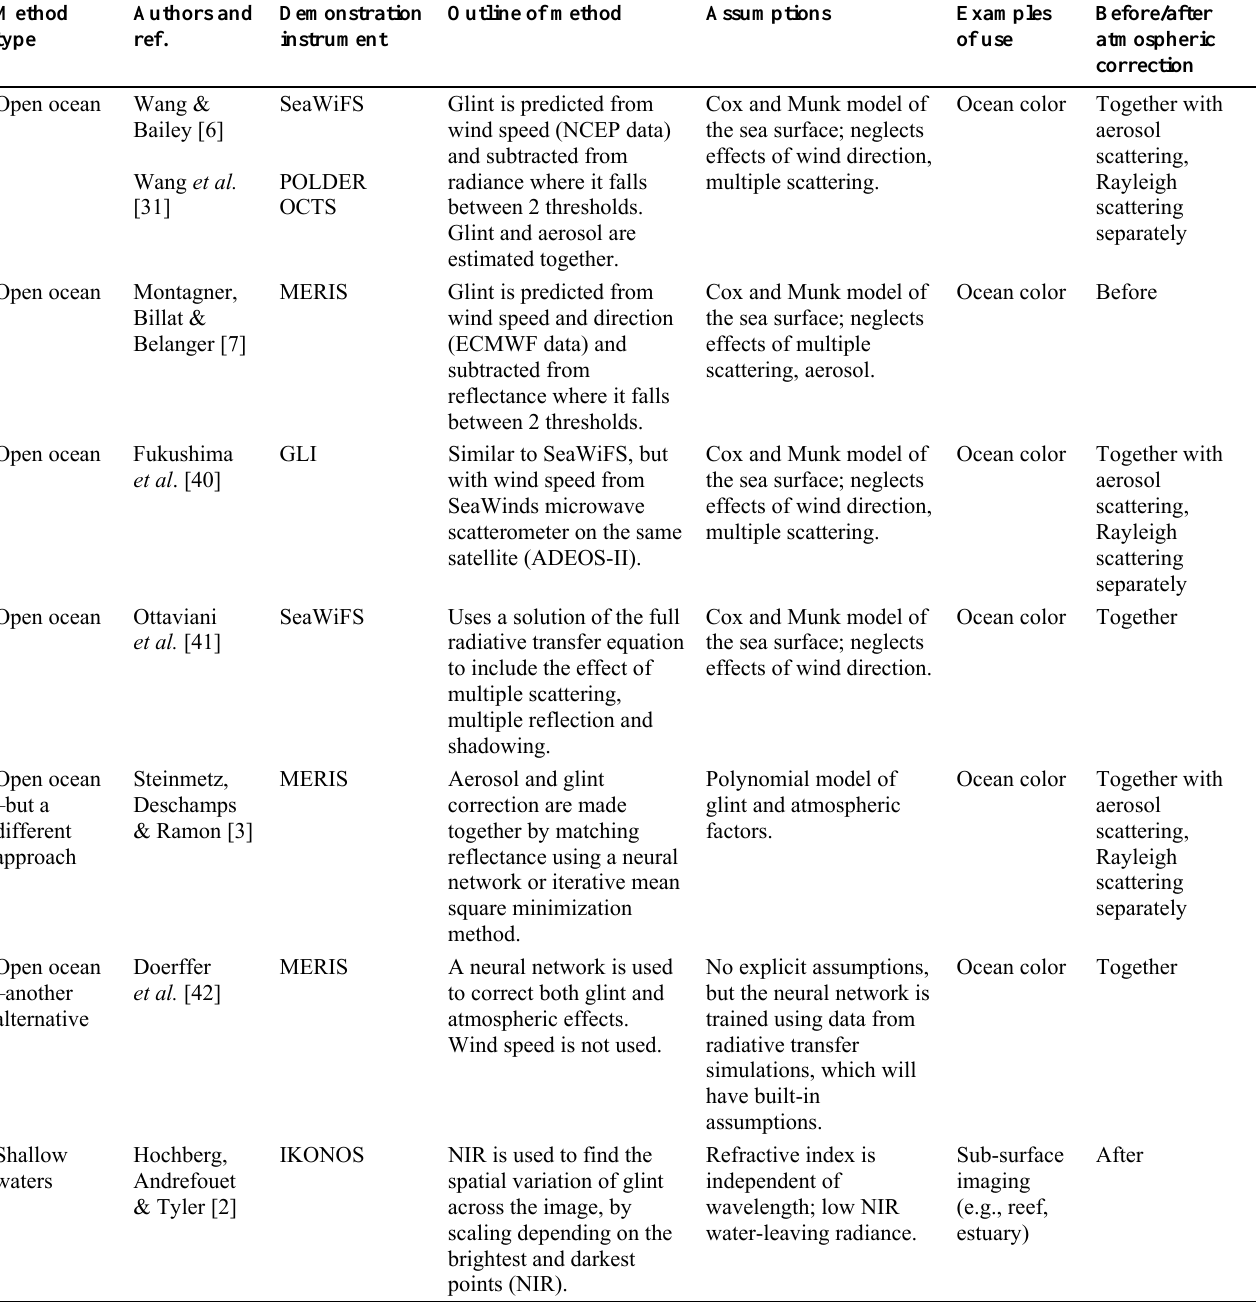
Table 4. Summary of sun glint correction